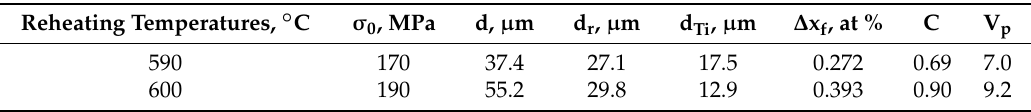
Table 4. Measured values of σ 0 , d Ti , d r and ∆ x f , and calculated values of C and V p for the composites thixoformed at reheating temperatures of 590 ◦ C and 600 ◦